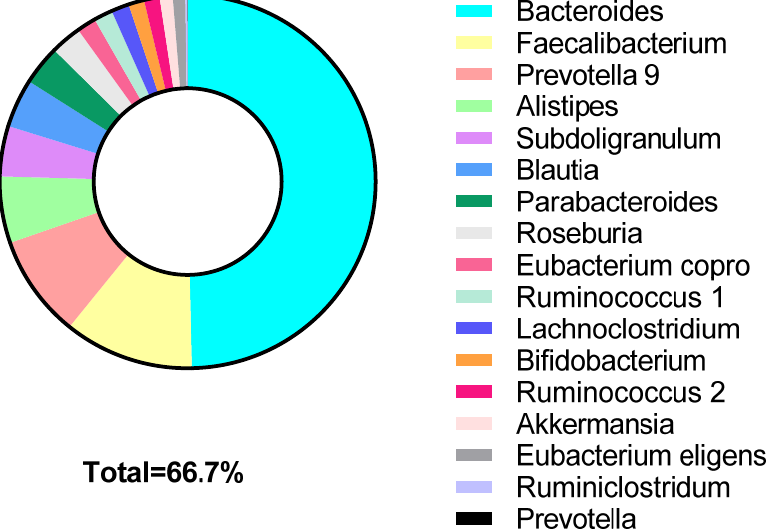
Figure 2. Cumulative relative abundance of genera classified as key microbiota. The selected taxa represent 66.7% of the abundance in participants.